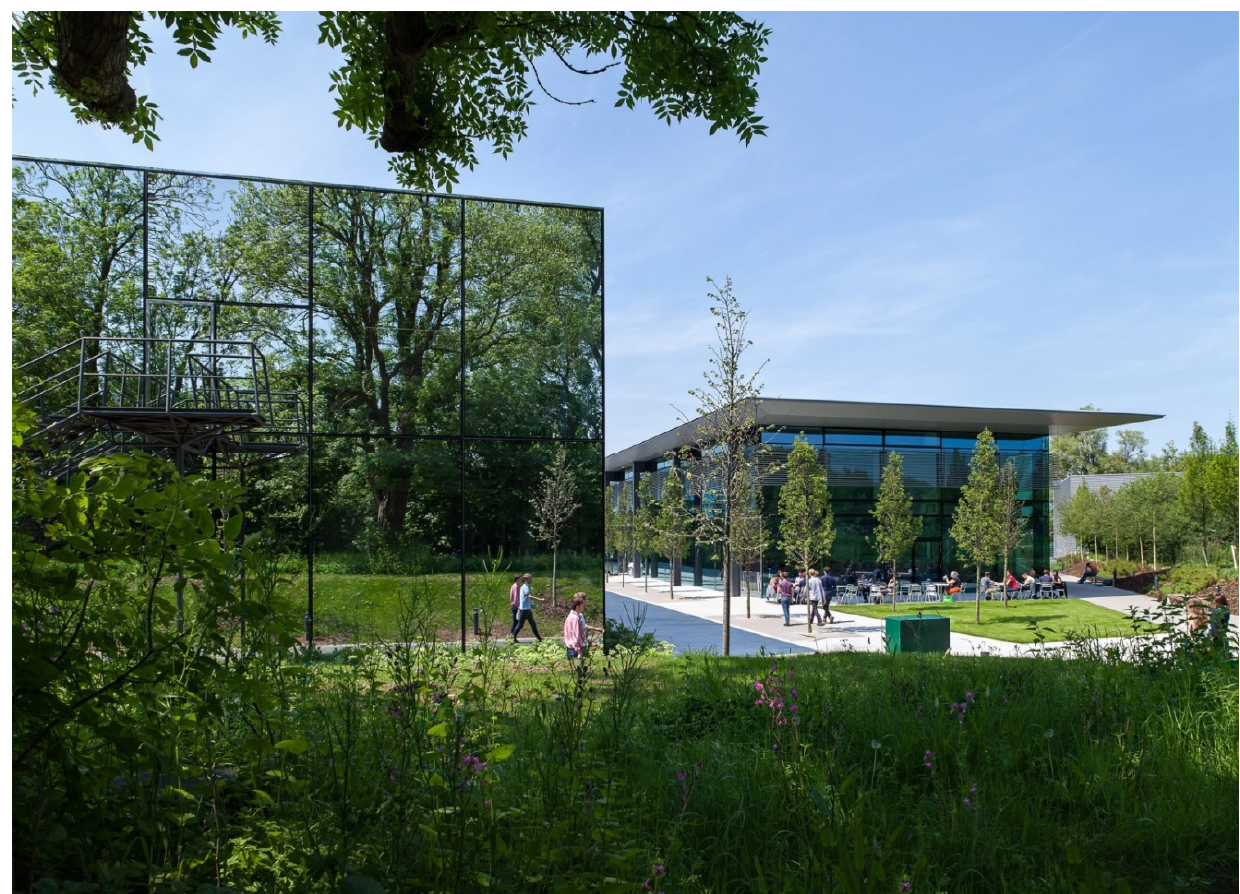
Figure 10. Mirror images of the surrounding landscape on the facade of the Dyson 9 building in Malmesbury. Photo: © Peter Landers and WilkinsonEyre.